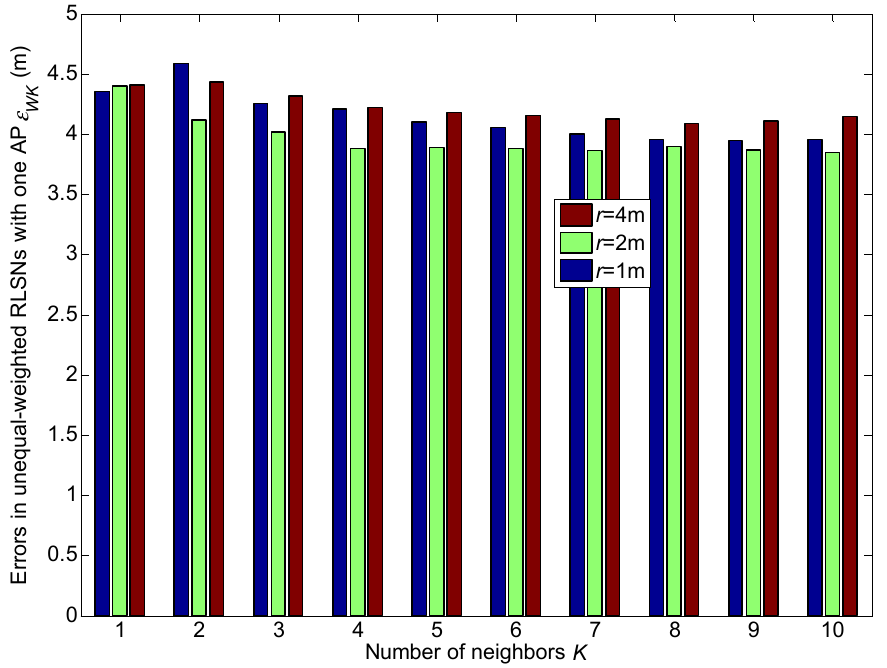
Figure 18. Localization errors in unequal-weighted RLSNs with one AP (AP1).